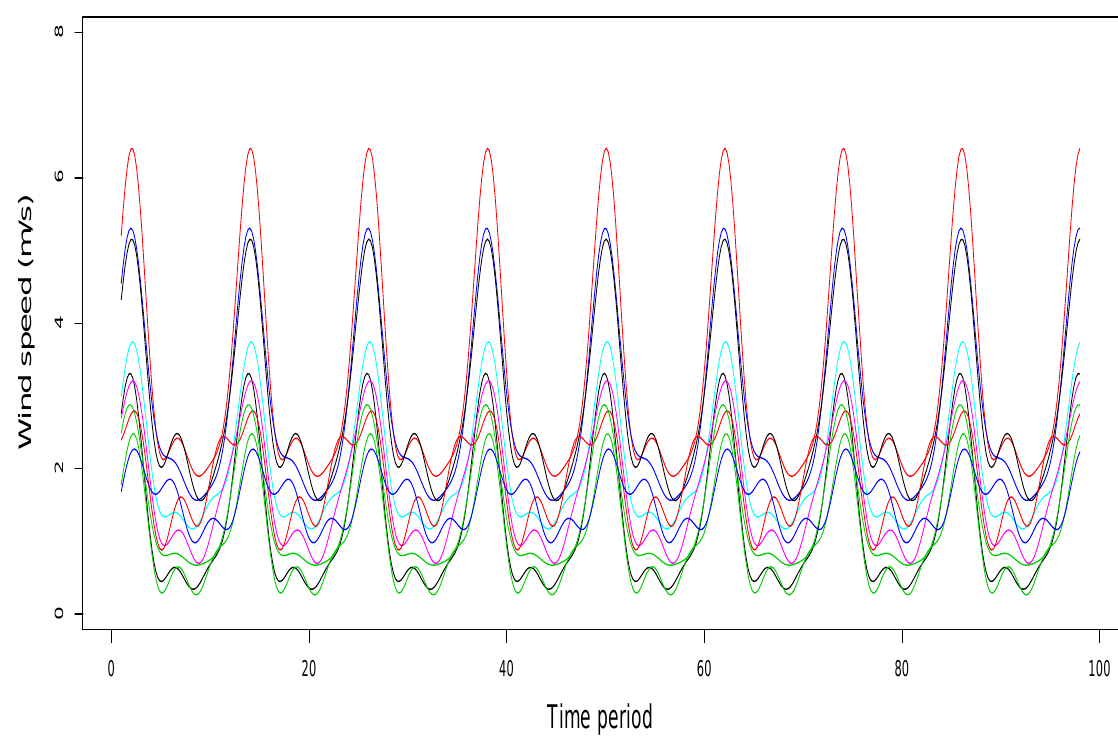
Figure 3. WS curves obtained by smoothing the data set of each station using a Fourier basis (of dimension k = 7). Time period 1 corresponds to 10:00 a.m. 26 January 2011 and time period 98 to 12:00 p.m. 3 February